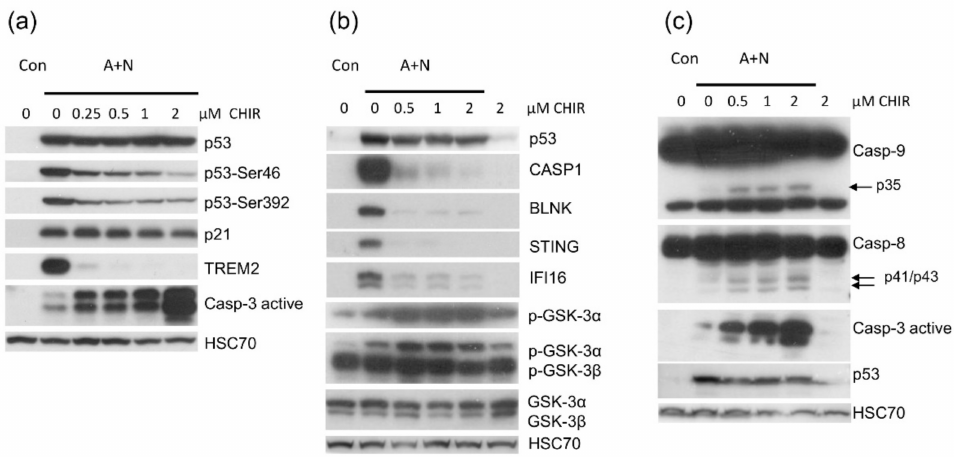
Figure 5. CHIR-98014 promotes activation of executioner caspase of apoptosis in A549 cells exposed to A + N. ( a ) Western blot showing expression of indicated proteins (or p53 phosphorylated on Sr46 or Ser392) in A549 cells mock-treated (Con) or incubated for 48 h with actinomycin D and nutlin-3a (A + N) with or without addition of CHIR-98014 at indicated concentrations. The level of active caspase-3 is also indicated. ( b ) Expression of proteins in A549 cells exposed as indicated. The phosphorylation of GSK-3 α on Ser21 was assessed using antibody anti-phospho GSK-3 α (Ser21). The phosphorylation of GSK-3 β on Ser9 was assessed using antibody anti-phospho GSK-3 β (Ser9), which also detects phosphorylated GSK-3 α (upper band). ( c ) The expression of cleaved forms of caspase-8 and caspase-9 (arrows) and the activated caspase-3 in A549 cells exposed as indicated. In all experiments from this figure cells were incubated with the substances for 48